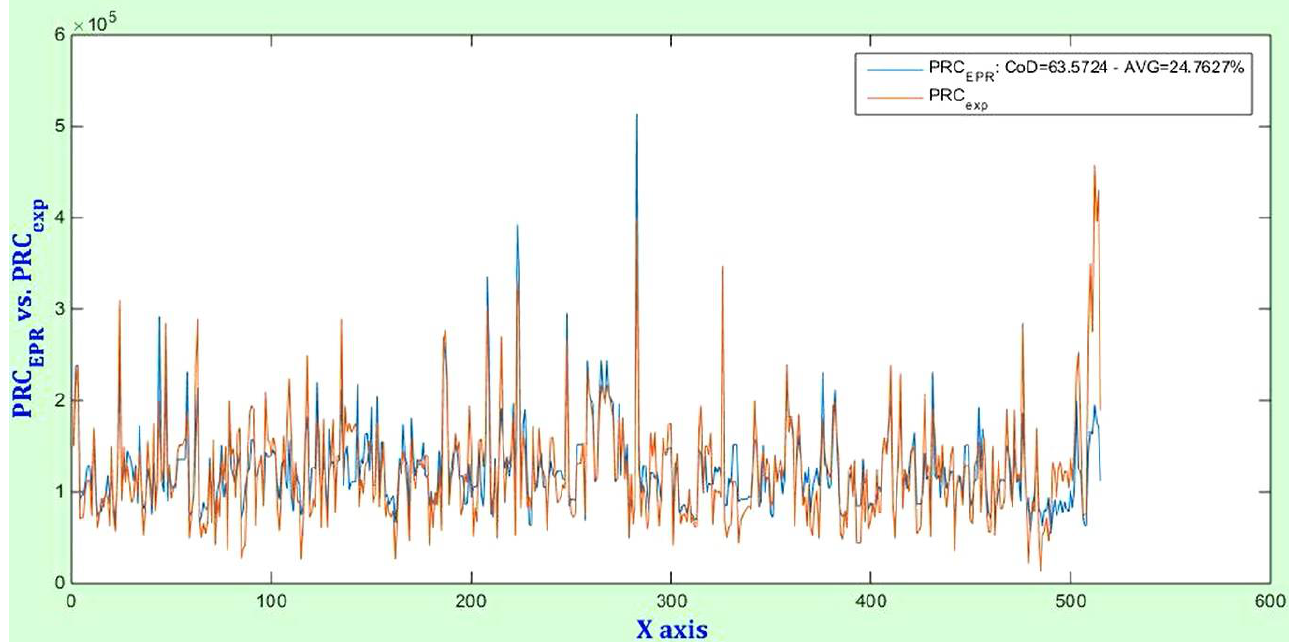
Figure 2. Selling price determined by EPR-MOGA (PRC EPR ) vs. selling price expected for model II (PRC exp ).